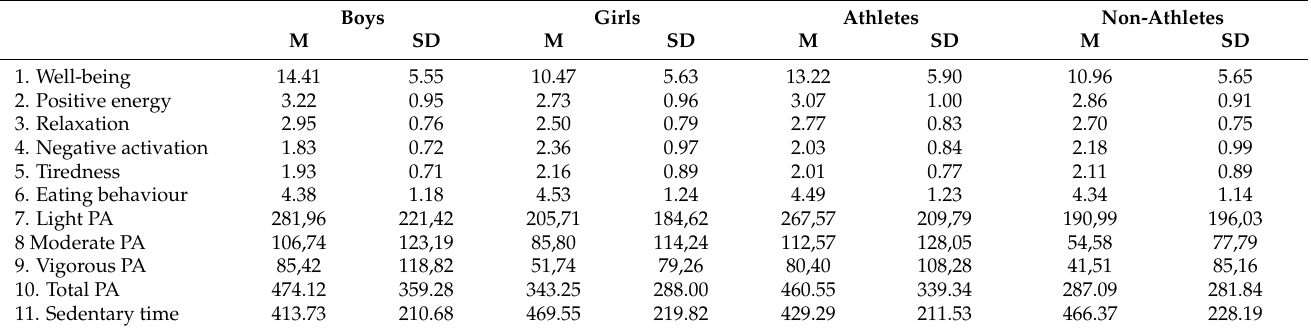
Table 2. Mean scores for all